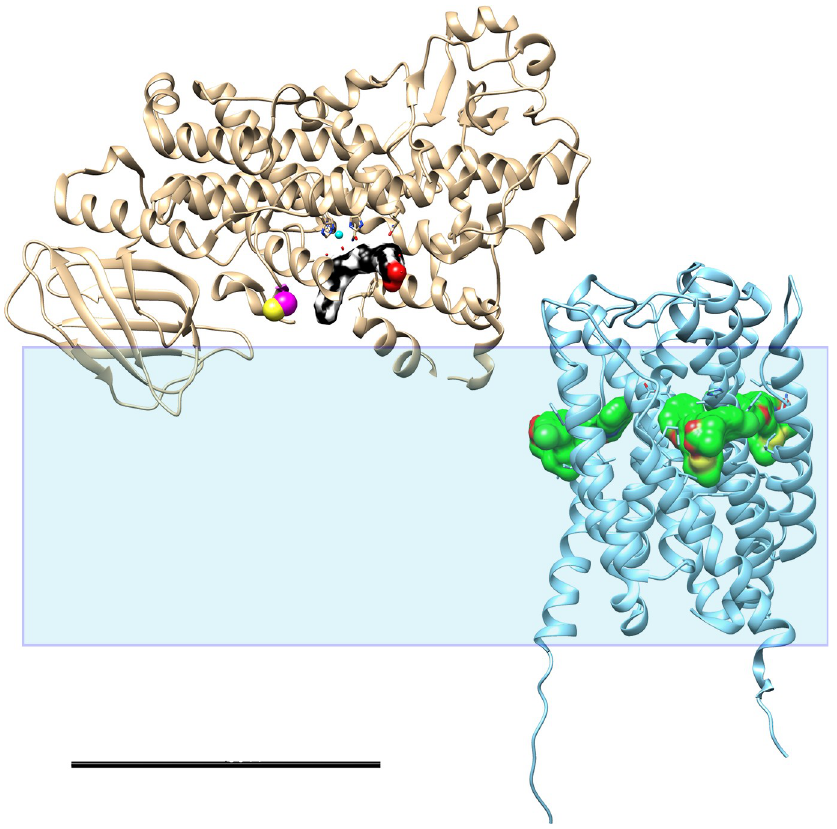
Fig 2. Schematic view of 5LO and FLAP embedded in the membrane. Ribbon models of 5LO (left, PDB ID: 3V99) and FLAP (right, PDB ID: 2Q7M) shown in relation to the membrane, highly schematically represented by the transparent rectangle which is 5 nm thick. It is not known how deep 5LO penetrates the membrane or how much FLAP protrudes from the membrane. The substrate AA in 5LO (black carbon atoms, red oxygens) and three inhibitor molecules (MK-591) in FLAP (green carbon atoms, red oxygens, yellow sulphurs) are shown in surface representation. In 5LO the non-haem iron (cyan) is surrounded by three histidines and water whereas the Cys159 shown to mediate binding to FLAP [16] is shown as spheres (yellow, magenta). Scale bar 5